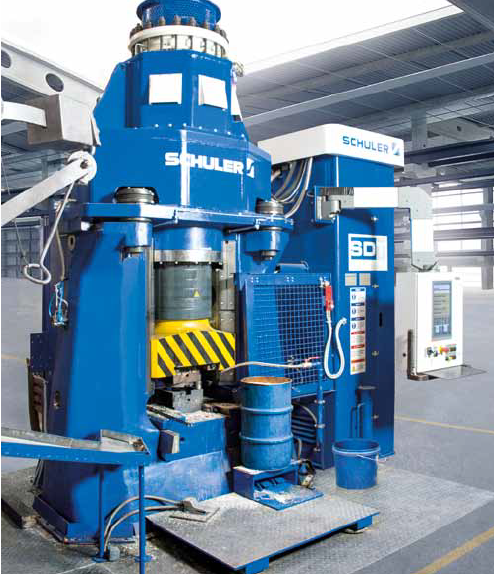
Figure 9. New linear electric forging hammer (Schuler